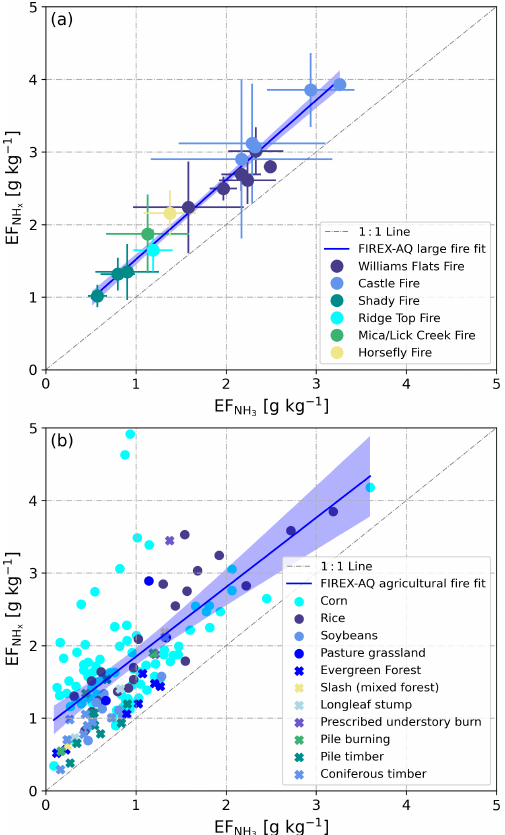
vs. EF NH as derived from in situ measurements Figure 5. EF NH x 3 in the plumes of (a) 6 wildfires and (b) 66 small agricultural fires. In panel (a) , SD bars represent the observed natural variability (mea- surement uncertainties in NH 3 and NH x not included). In panel (b) , circles represent field-dominated fuels and crosses represent timber- dominated fuels (see Sect. 3.3). The blue lines represent linear re- gression curves of the average values for wildfires (a) and of all agricultural data in (b) . Shaded areas are 95% confidence bands.